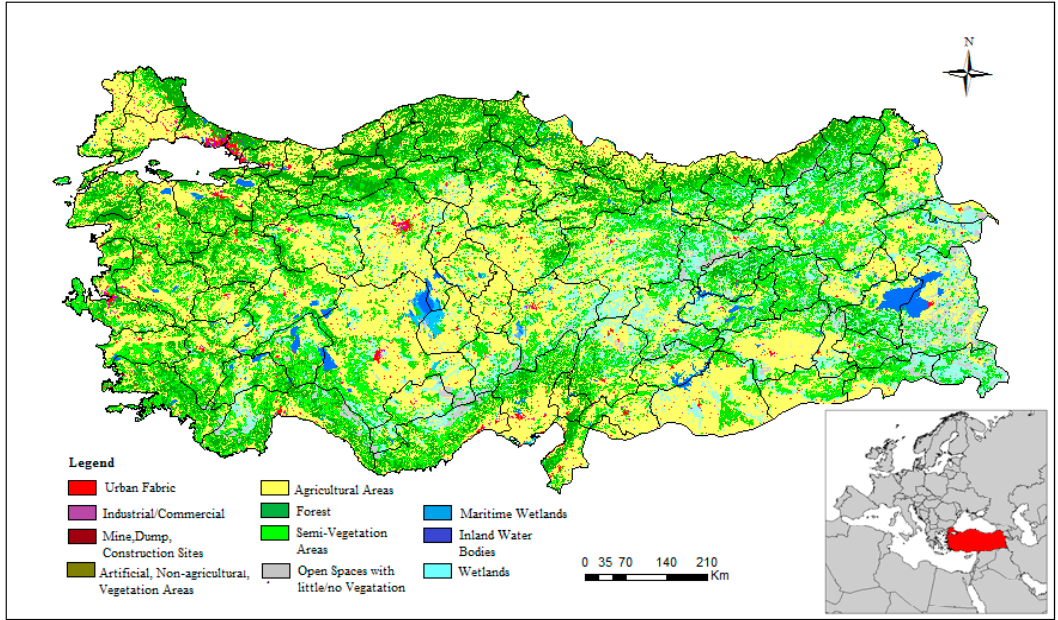
Figure 4. The study area of Turkey. Land use/cover classes visualized with 100 m resolution.